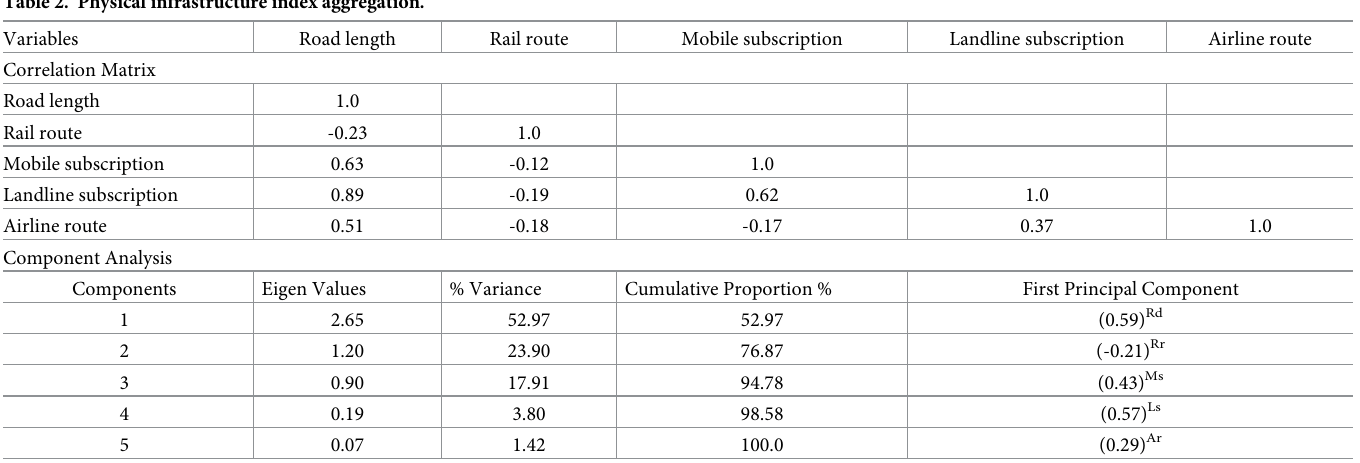
Table 2. Physical infrastructure index aggregation.